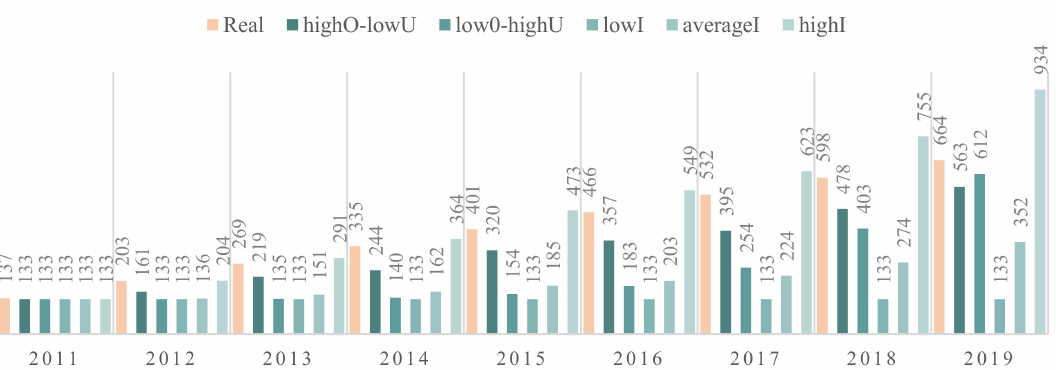
Figure 6. Experiments on the quality of the model with extreme population